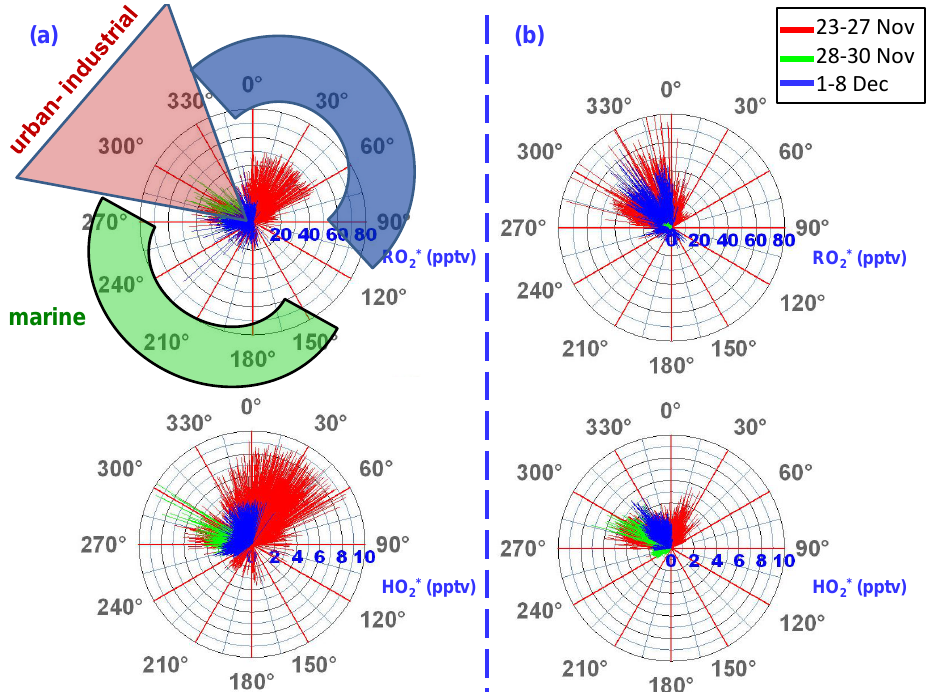
Fig. 5. Distribution of RO ∗ measured by DUALER according to local wind direction for the time periods of similar meteorology defined 2 in Sect. 3.1: 23 to 27 November, 28 to 30 November and 1 to 7 December 2008. Data for (a) photochemical (06:00–17:00UTC) and (b) non-photochemical (00:00–06:00 and 17:00 to 24:00UTC) radical production are plotted separately. HO ∗ depicted for comparison (lowermost windroses). Wind sectors are indicated as additional information.